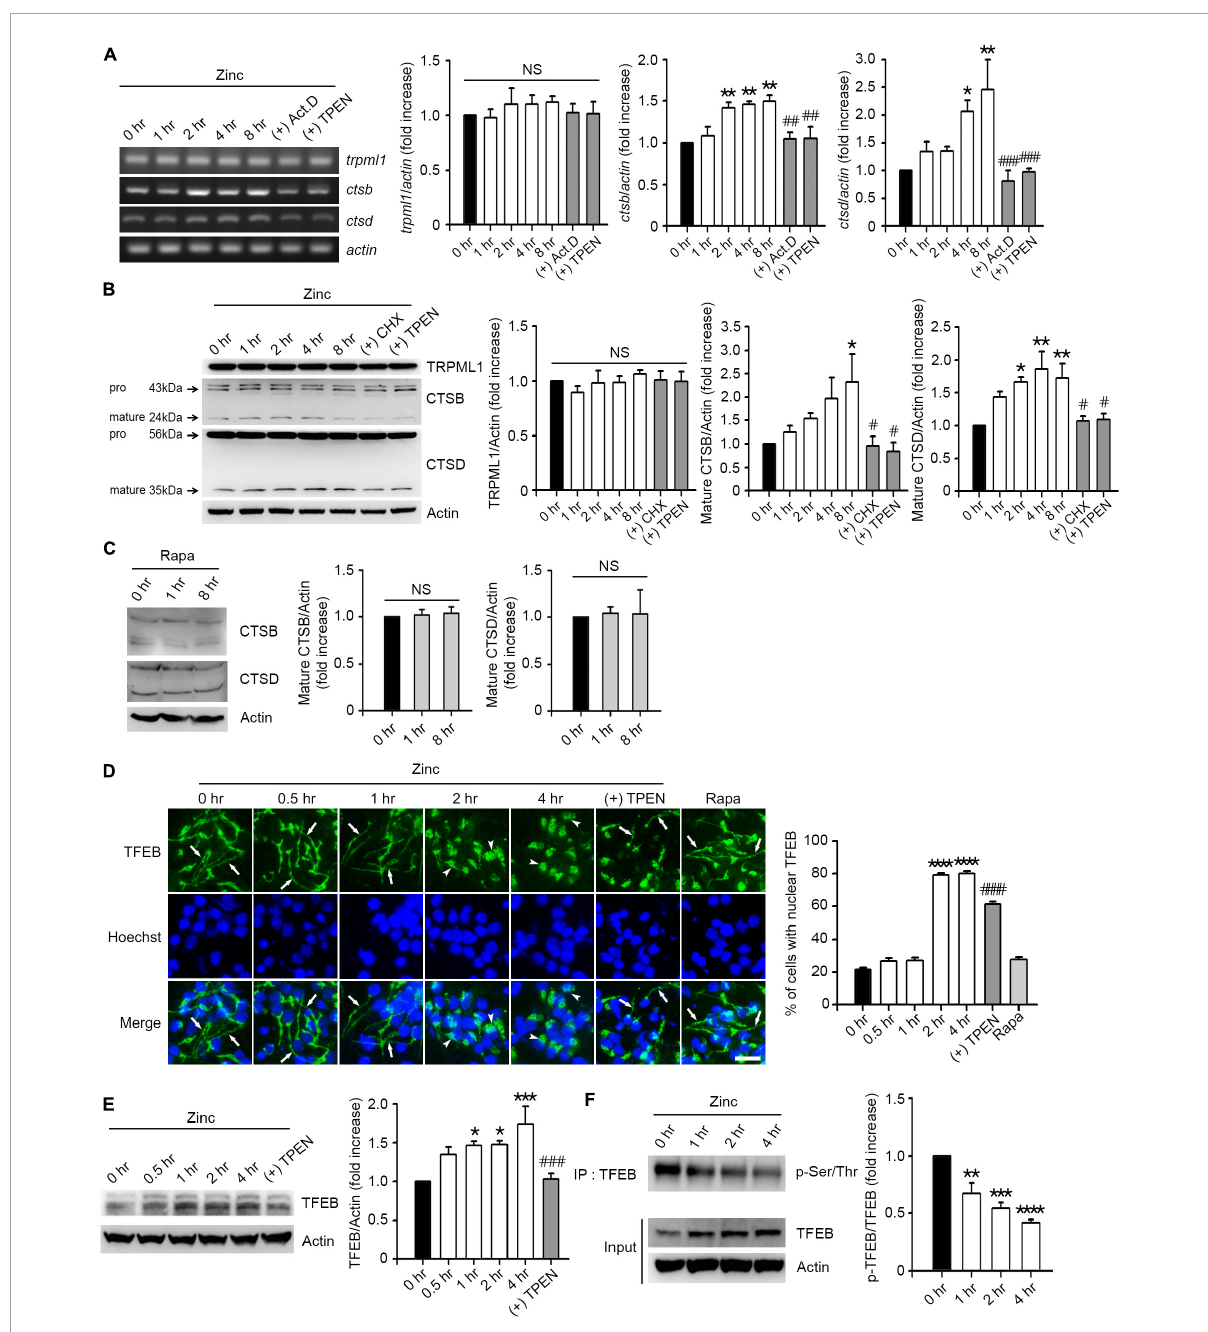
FIGURE3 Zinc induces de novo synthesis of CTSB and CTSD via TFEB activation. (A) Reverse-transcription polymerase chain reaction (RT-PCR) analysis for trpml1 , ctsb , and ctsd in mouse cerebrocortical cultures. mRNA samples were prepared at the indicated time points after exposure to 25 µ M ZnCl 2 (Zinc) with or without 1 µ g/ml actinomycin D (+Act.D) or 500 nM TPEN (+TPEN). Quantification of mRNA levels of trpml1 , ctsb , and ctsd was performed in ≥ 3 independent biological replicate experiments. * p < 0.05 or ** p < 0.01 vs. CTRL (0 h), and ## p < 0.01 or ### p < 0.001 vs. zinc (8 h) by ANOVA with post hoc Dunnett’s test. There was no significant difference in trpml1 mRNA levels (NS). (B,C) Western blot analysis for TRPML1, CTSB and CTSD in mouse cerebrocortical cultures. Proteins were prepared at the indicated time points after exposure to 25 µ M ZnCl 2 (Zinc) with or without 10 µ g/ml cycloheximide (+CHX) or 500 nM TPEN (+TPEN) (B) , or 100 nM rapamycin (Rapa) (C) . Quantification of TRPML1 and mature forms of CTSB and CTSD was performed in ≥ 3 independent replicate experiments. * p < 0.05 or ** p < 0.01 vs. CTRL (0 h), and # p < 0.05 vs. zinc (8 h) by ANOVA with post hoc Dunnett’s test. There was no significant difference between sham wash control and